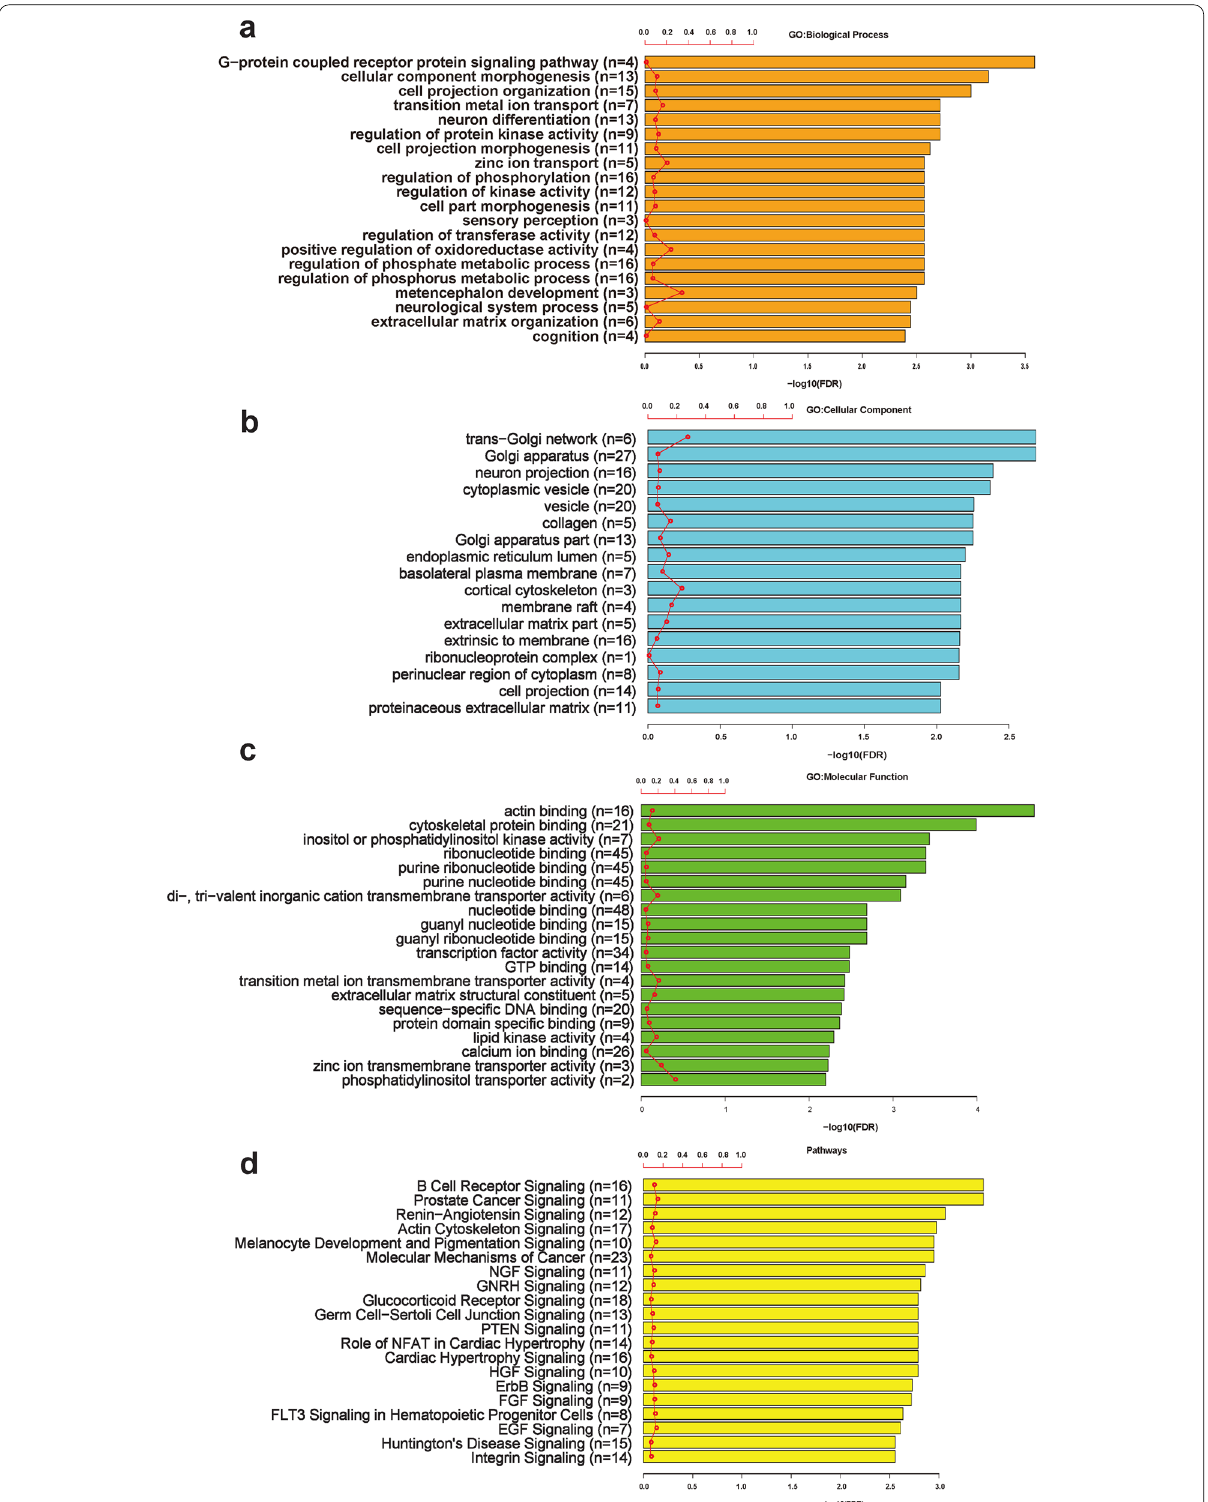
Fig. 4 Enrichment analysis of target genes of hsa-miR-9-5p. a GO (BP) enrichment analysis. b GO (CC) enrichment analysis. c GO (MF) enrichment analysis. d KEGG enrichment